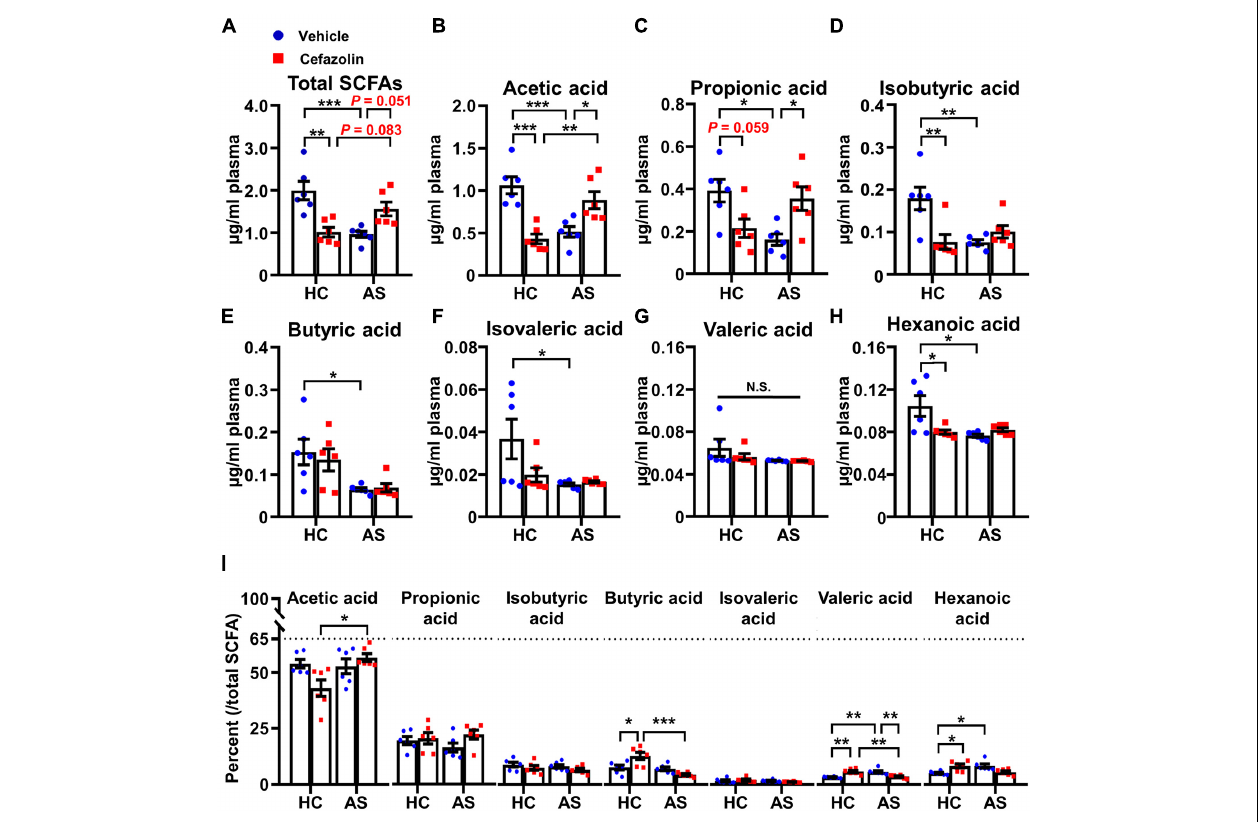
FIGURE 6 | Cefazolin changed the contents of plasma SCFAs in the HC and AS groups. (A) Total SCFAs, (B) Acetic acid, (C) Propionic acid, (D) Isobutyric acid, (E) Butyric acid, (F) Isovaleric acid, (G) Valeric acid, (H) Hexanoic acid, and (I) The percent of each SCFA relative to total SCFAs. Data are shown as mean ± S.E.M. ( n = 6 in each group). * P < 0.05, ** P < 0.01 or *** P < 0.001. AS, anesthesia and surgery; HC, healthy control; N.S., not significant; SCFAs, short chain fatty